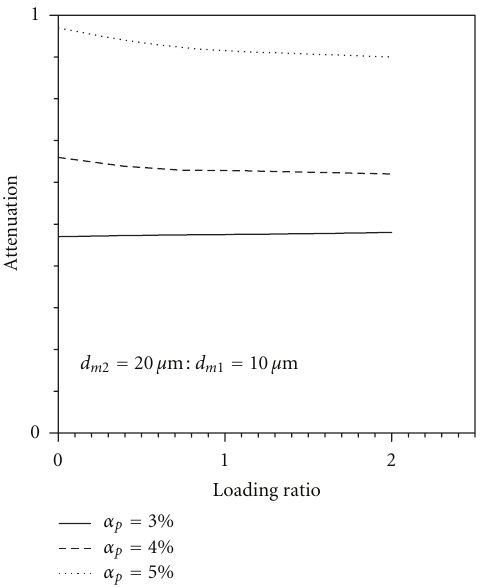
Figure 15: Nondimensional attenuation as function of particle diameter ( d m 2 : d m 1 ), for a 1: 1 loading distribution for two sets of particles at total loading of 3%, reference motor, acceleration